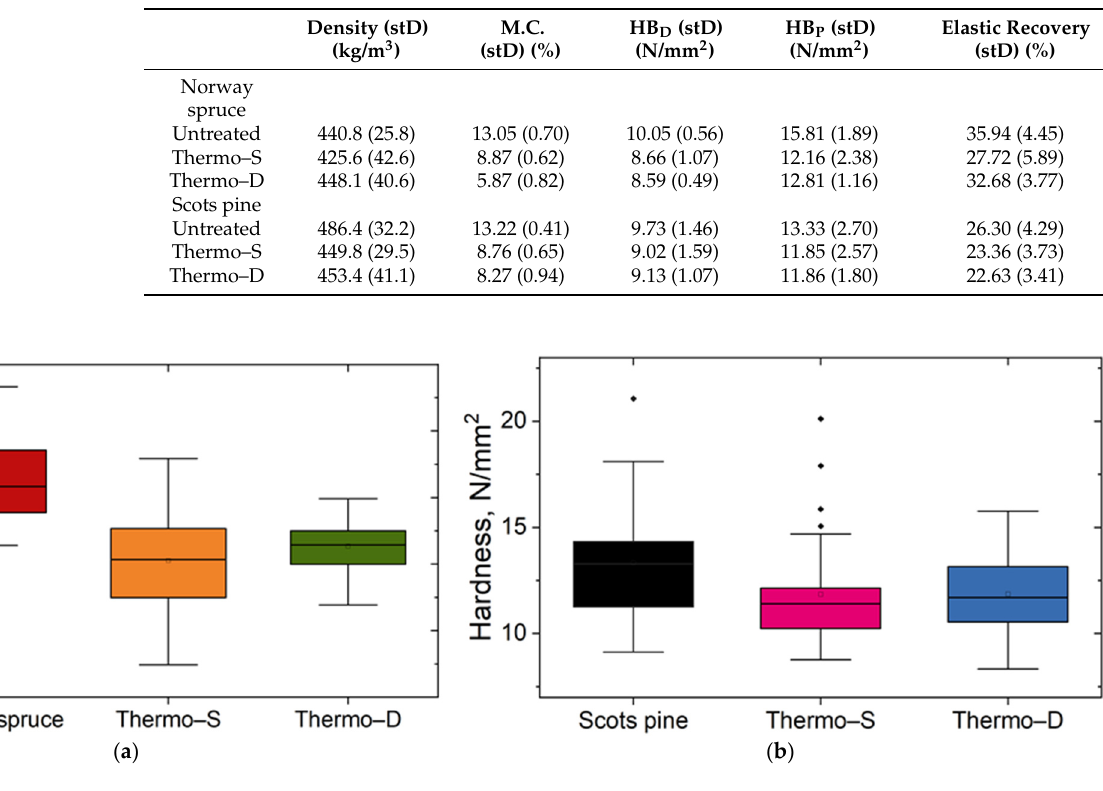
Figure 10. Brinell hardness after release of force (HB P ) measured for the untreated and ThermoWood ® Norway spruce ( a ) and Scots pine ( b ).